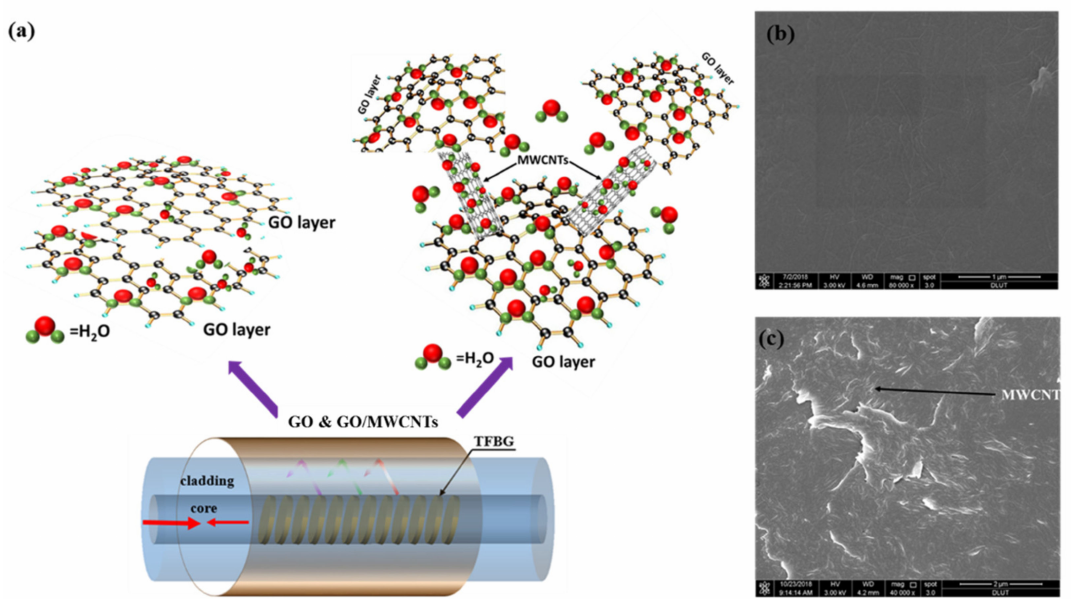
Figure 2. The GO or GO/MWCNTs hybrid nanomaterial sensing film. ( a ) Schematic diagrams ‘of the humidity sensor based on GO or GO/MWCNTs; ( b , c ) SEM diagrams of surface of TFBG coated with GO or